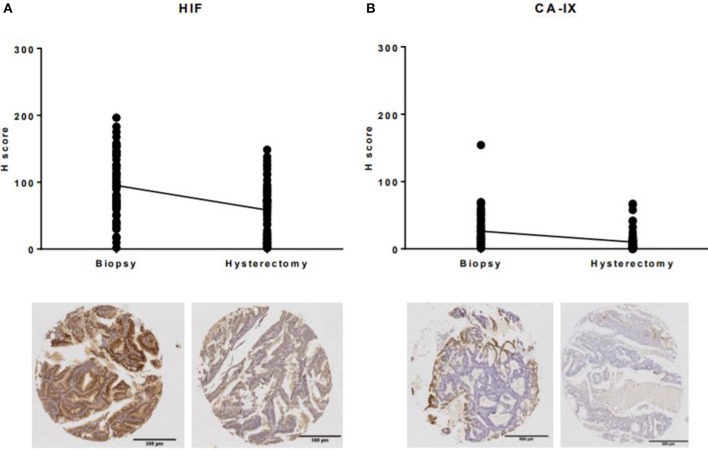
Expression of hypoxia markers in endometrial biopsies and corresponding hysterectomy specimens. (A) The mean H-score for HIF-1α decreased from 95.1 (SD 46.9) in the endometrial biopsy to 58.2 (SD 39.9) in the hysterectomy specimen, (B) the mean H-score for CA-IX decreased from 26.2 (SD 26.9) to 10.1 (SD 15.5).